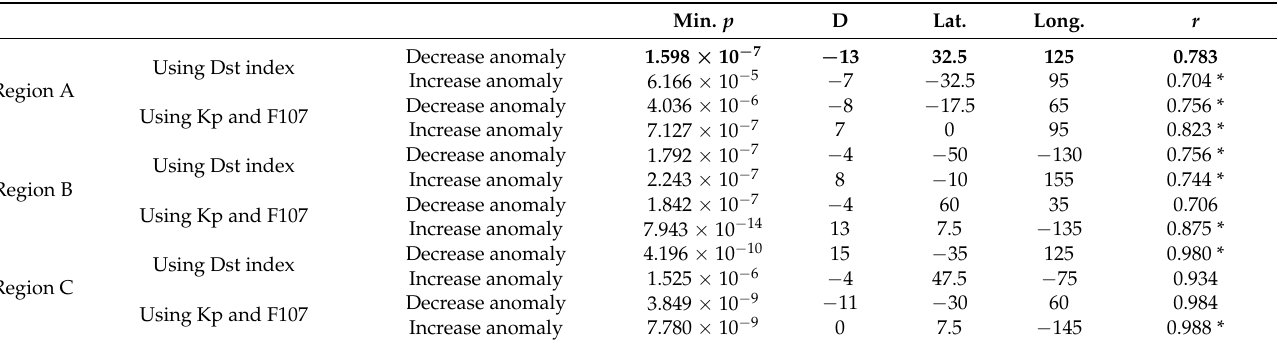
Table 5. Same as Table 4 for the results of the declustered samples with energy releases ≥ M 5.5 with outliers shown in Supplementary Material